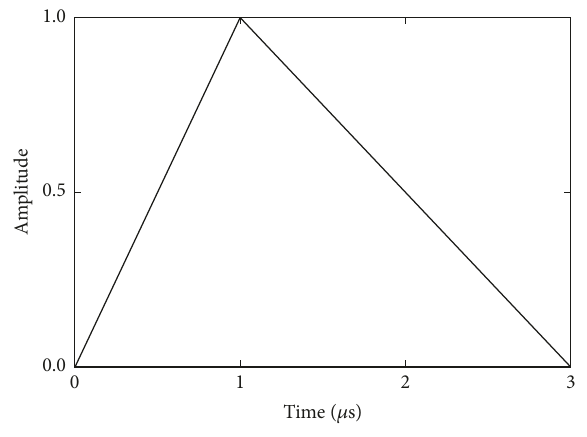
Figure 3: Excitation